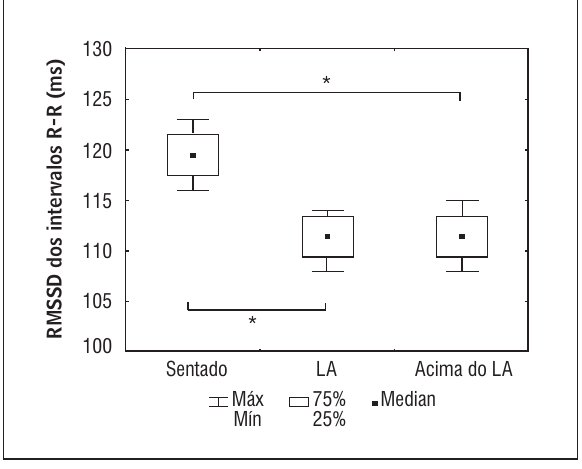
Figura 2 - Valores do índice RMSSD (ms) obtido em repouso sentado e nas velocidades do LA e acima do LA Legenda: LA = limiar de anaerobiose; * = p <